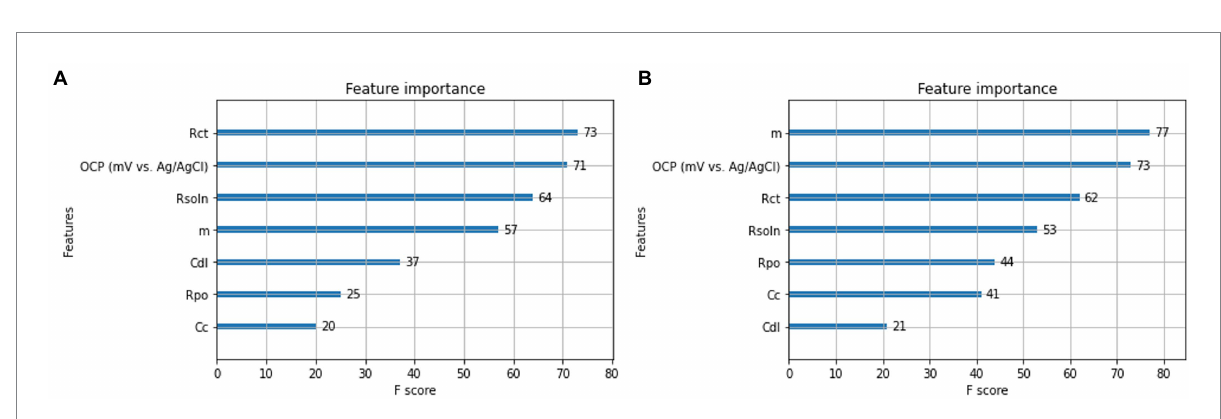
FIGURE 8 Feature component analysis using XGBoost. Of (A) VAE based synthetic data (B) GAN based synthetic